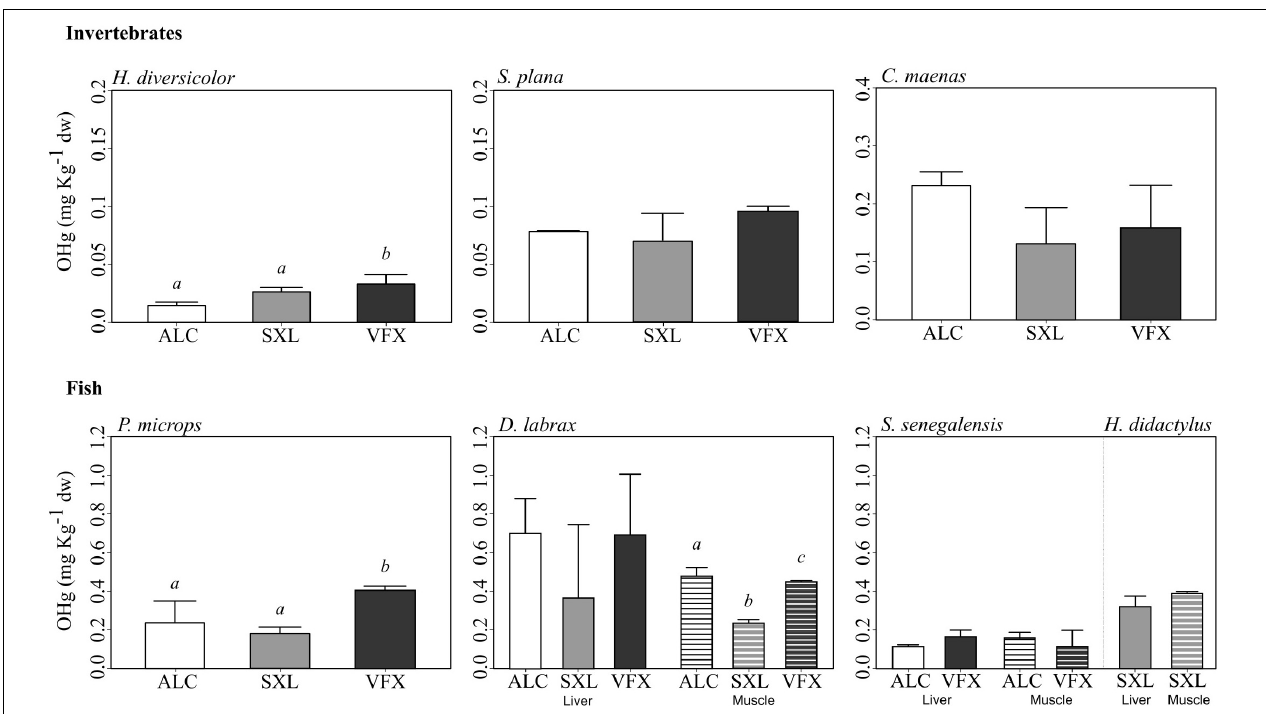
FIGURE 3 | Mean organic mercury (OHg) concentration (mg kg − 1 dry weight) and standard deviation in invertebrates and fish species collected in three sites in the Tejo estuary ( n = 3 replicates per species, tissue and site). H. diversicolor and P. microps were analyzed as whole individuals (due to small size), whilst digestive gland, muscle and liver were sampled in other invertebrate and fish species, respectively. In fish, solid bars and line patterns represent liver and muscle concentrations, respectively. Different letters indicate significant differences in OHg tissue concentration among sites per species. For trophic levels see Table 2